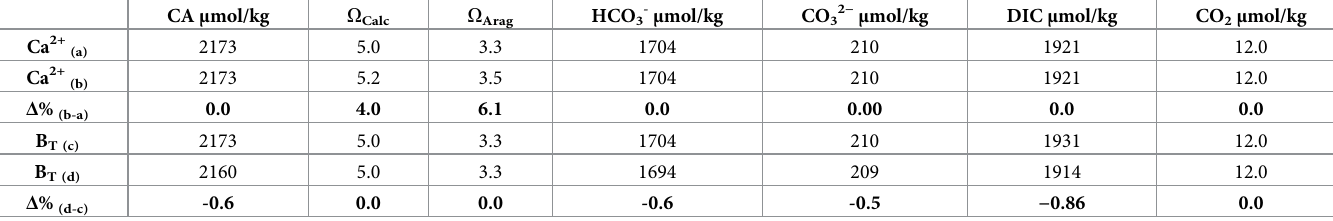
Table 6. Variations in the carbonate system parameters as a function of the minimum (a, c) and maximum (b, d) values found for Ca 2+ and B T (Table 5). Values obtained with the AQM program keeping the temperature (25˚C), salinity (35 g/kg), pH T (8.0), and TA (2300 μ mol/kg) variables constant at the program entry. The expected value is the analyzed